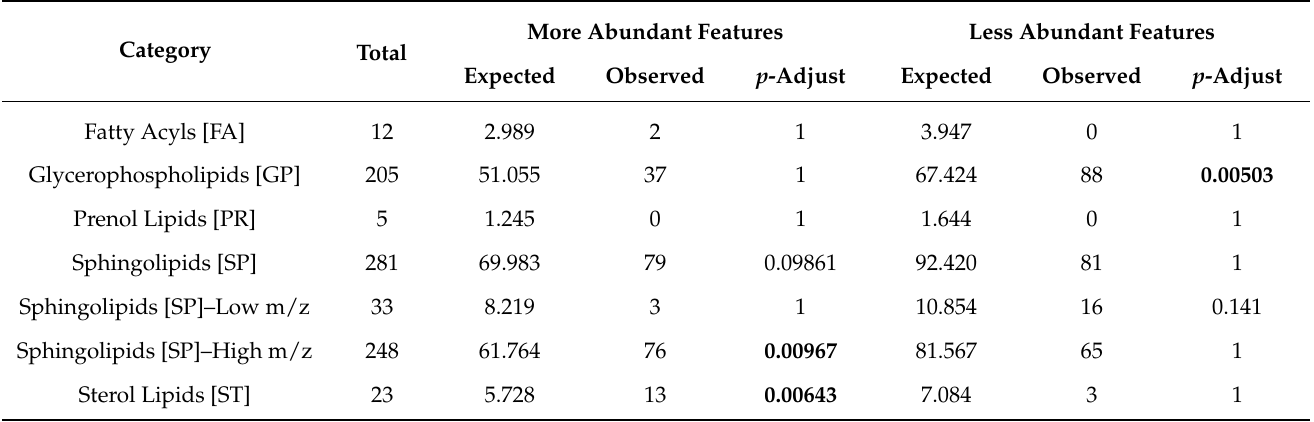
Table 1. Differential abundance analysis results at the lipid category